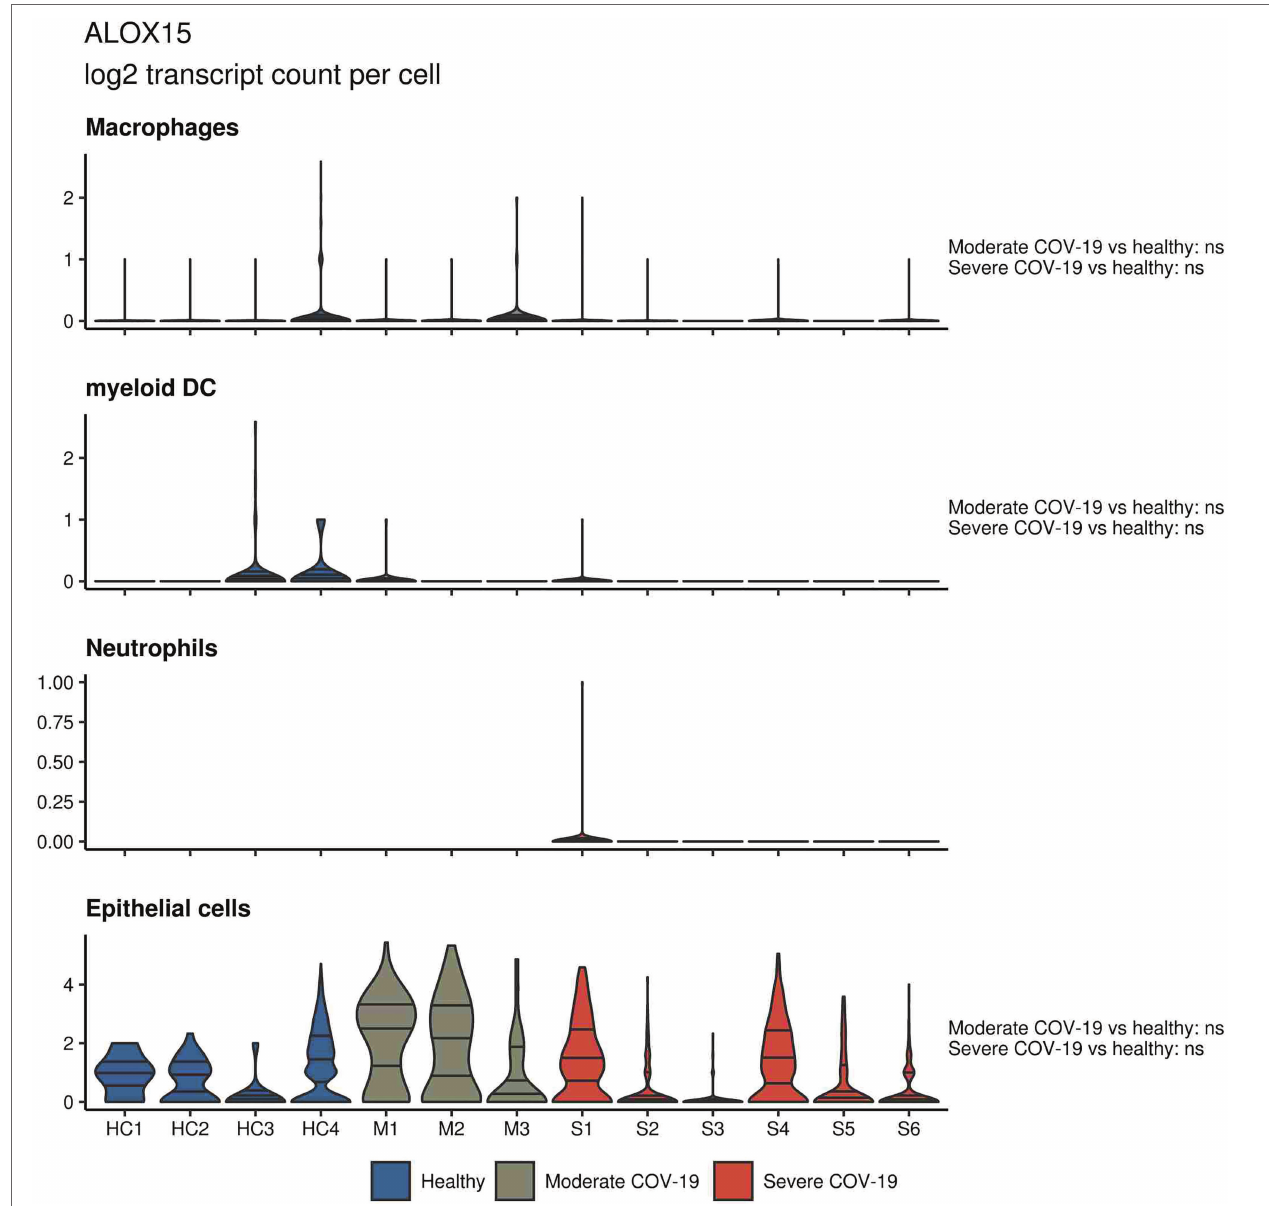
FIGURE 4 | ALOX15 expression in BALF cells from patients affected by COVID-19. Violin plots depicting ALOX15 expression levels within specific cellular populations in BALF cells from healthy (blue, n = 4), moderate (gray, n = 3), or severe (red, n = 6) COVID-19 patients. RNA sequencing data are publicly available (Liao et al., 2020). ns =